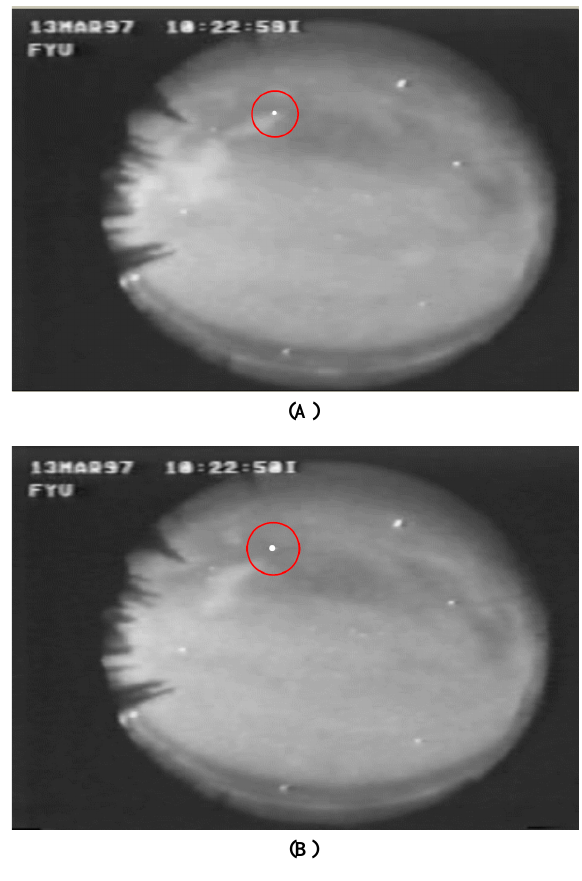
Fig. 1. Ft. Yukon all-sky camera video frames. Panel (A) shows the rocket position during a pulsation event at 10:22:59 UT. Panel (B) shows the rocket position at 10:22:50 UT, just prior to the pulsation event in panel (A).